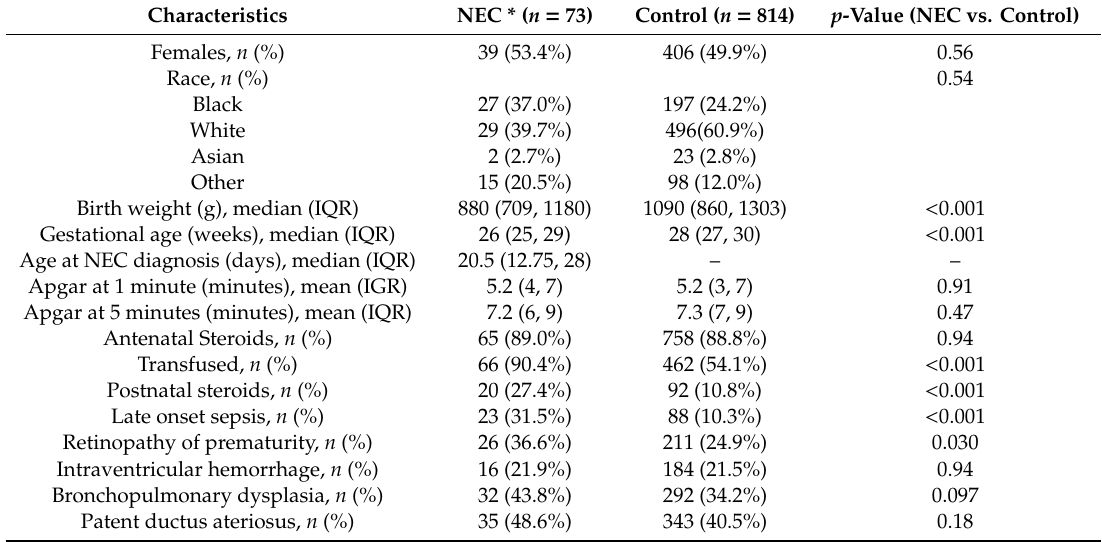
Table 2. Demographics and characteristics of cases and